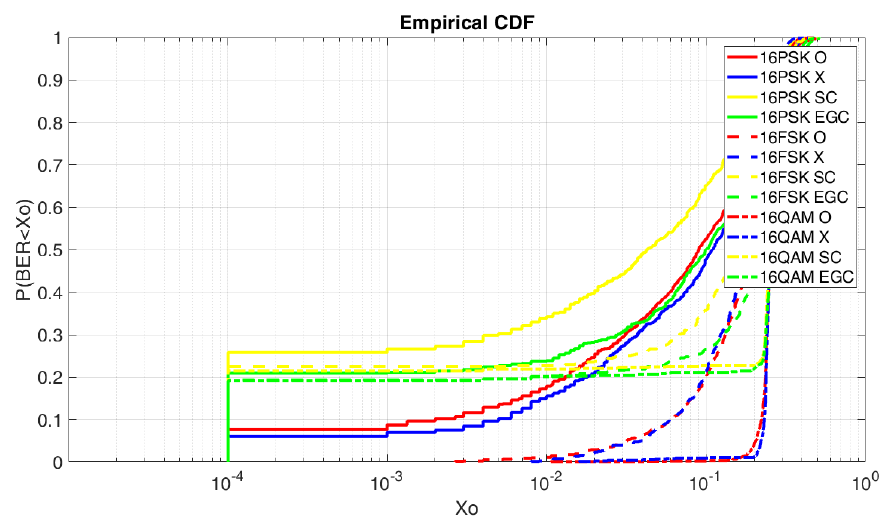
Figure 10. BER CDF order 16 modulations at 50 W.